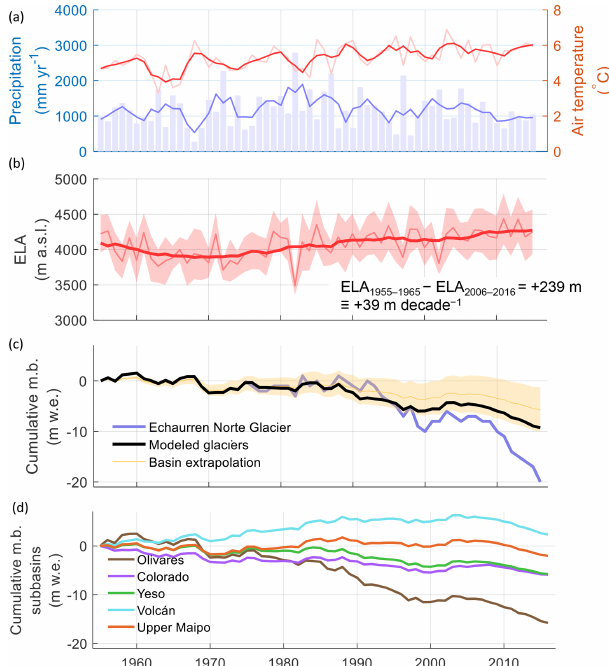
Figure 6. Variability of meteorological and glaciological variables in the Maipo River basin over the period 1955–2016: (a) air tem- perature and precipitation with a 3-year moving mean; (b) equilib- rium line altitude (ELA); (c) cumulative glacier mass balance for the modeled glaciers (simulated with TOPKAPI-ETH), the entire basin (extrapolation) and its associated uncertainty, and the mea- surements on Echaurren Norte Glacier; and (d) cumulative glacier mass balance for each sub-catchment. In (b) the difference between the ELA in the last 10 years (2006–2016) and the first 10 years (1955–1965) of the study periods is indicated, as is the equivalent ELA increase rate. The shadowed area in (b) shows the standard deviation of the elevation of grid cells with a mass balance between − 0 . 1 and